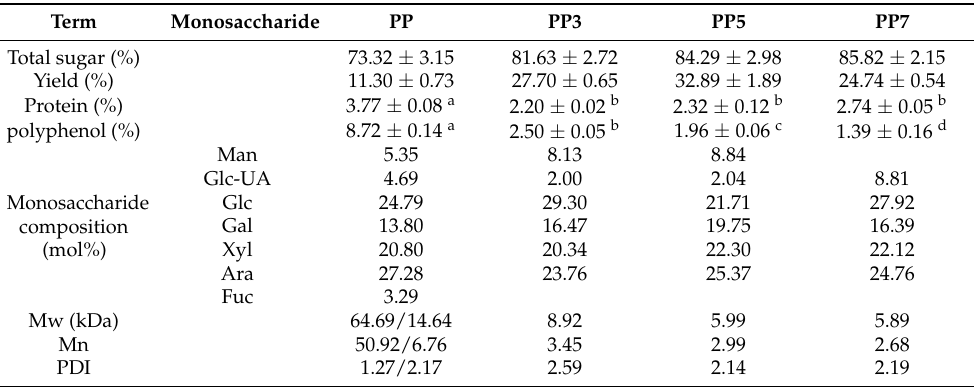
Table 3. Chemical component, monosaccharide composition molecular weigh of PP, PP3, PP5, and